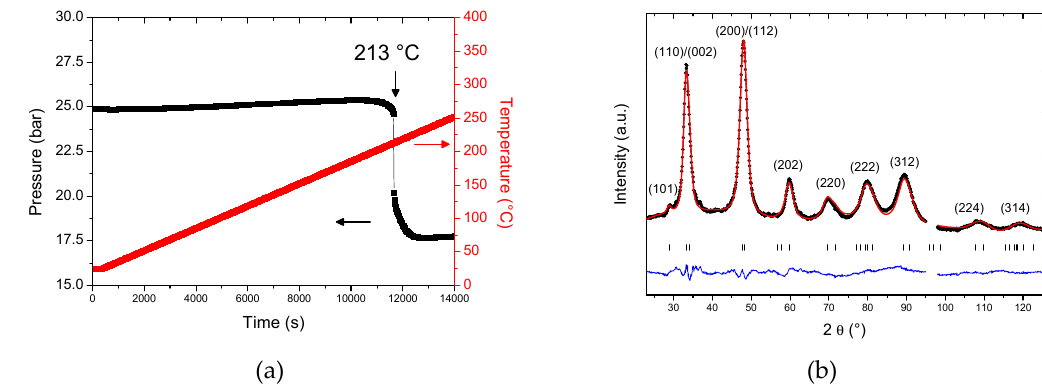
Figure 4. Pressure and temperature variations during deuterium absorption in Ti 0.325 V 0.275 Zr 0.125 Nb 0.275 (BM) (the temperature ramp is 1 °C/min) ( a ) and the neutron powder diffraction pattern of the deuteride phase Ti 0.325 V 0.275 Zr 0.125 Nb 0.275 D 1.73 (pattern recorded at room temperature) together with the Rietveld refinement (calculated pattern in red and the difference curve in blue) ( b ). The excluded zone from 95 to 97.5 ◦ is due to the powder diffraction contribution from the sample